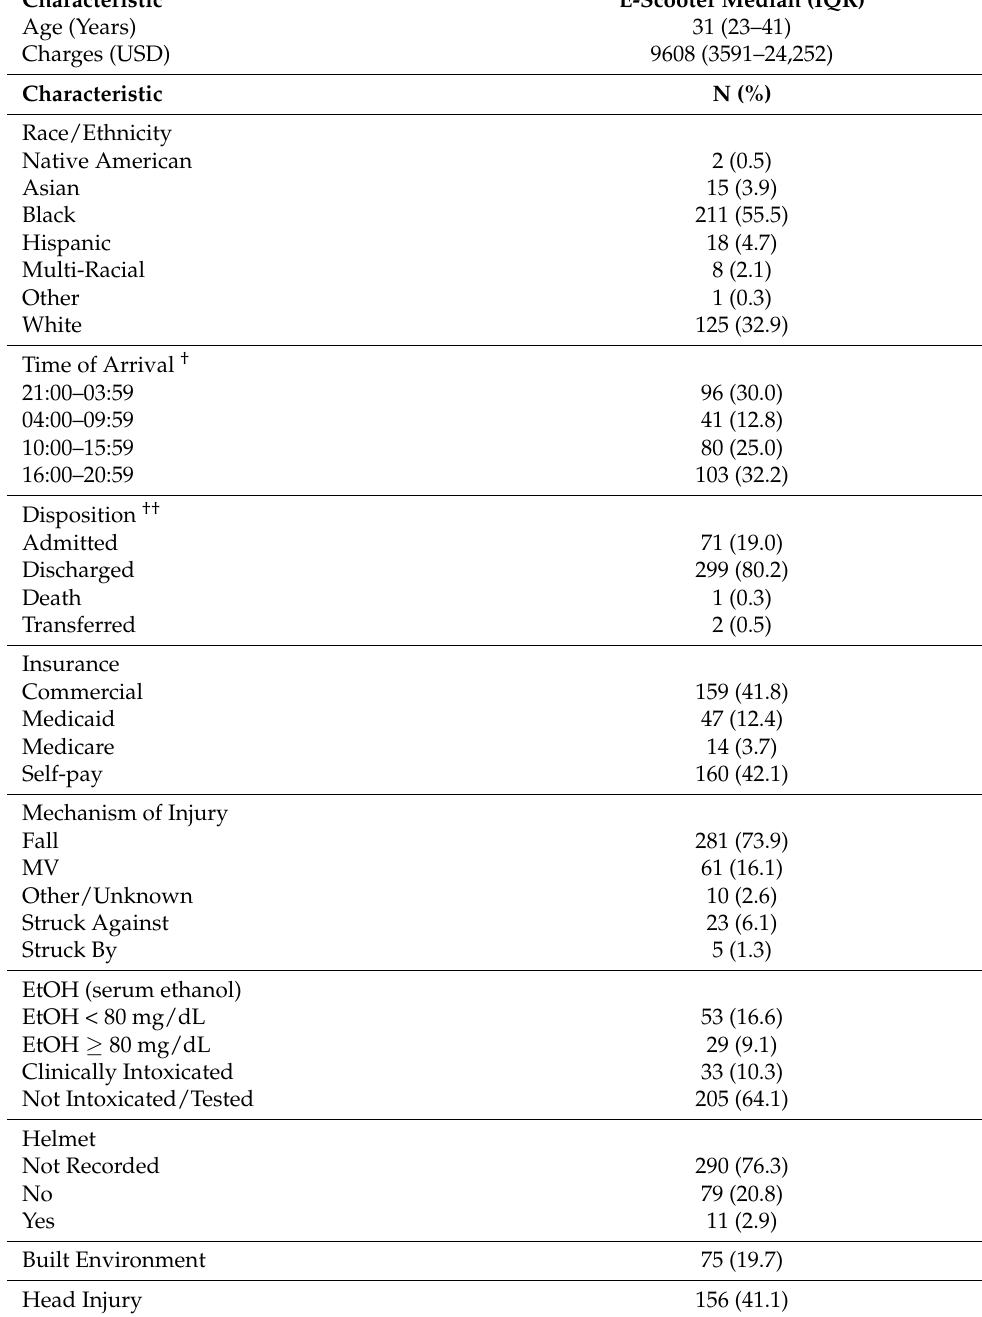
Table 2. Characteristics of Patients with Injuries with e-Scooters Injuries Classified as